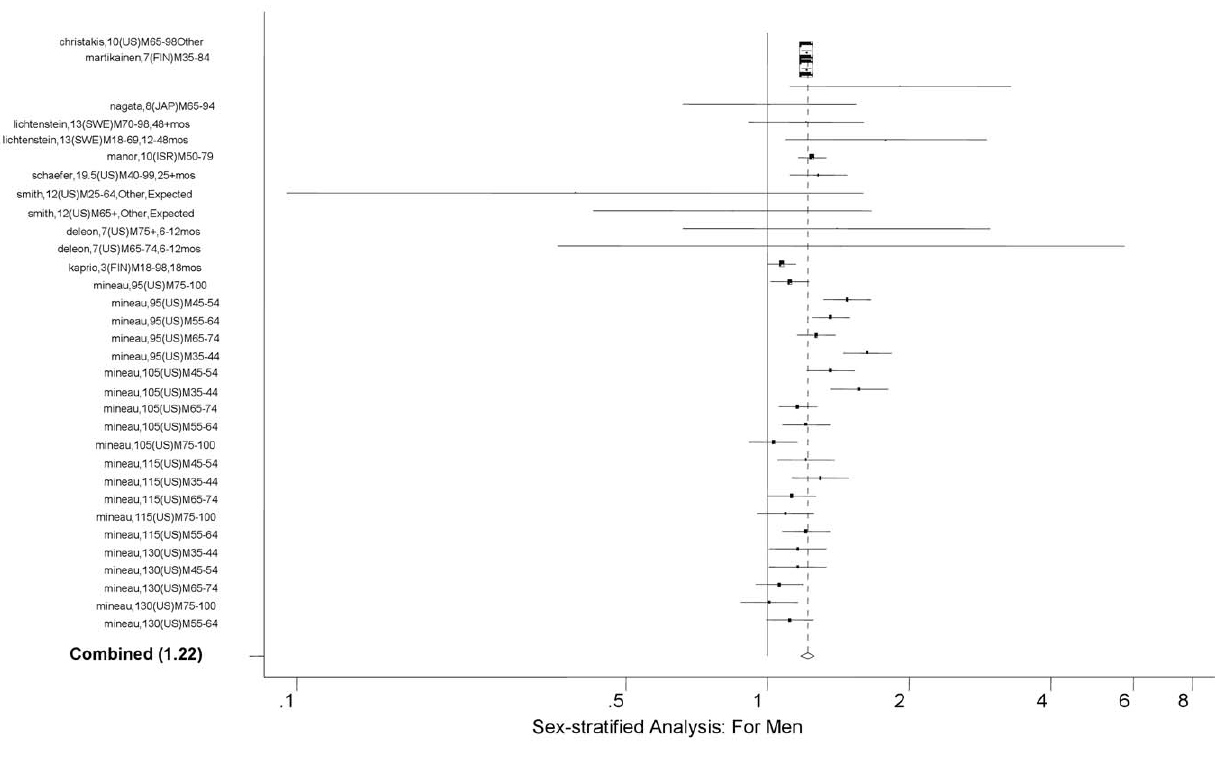
Figure 4. Forest Plot for Men.